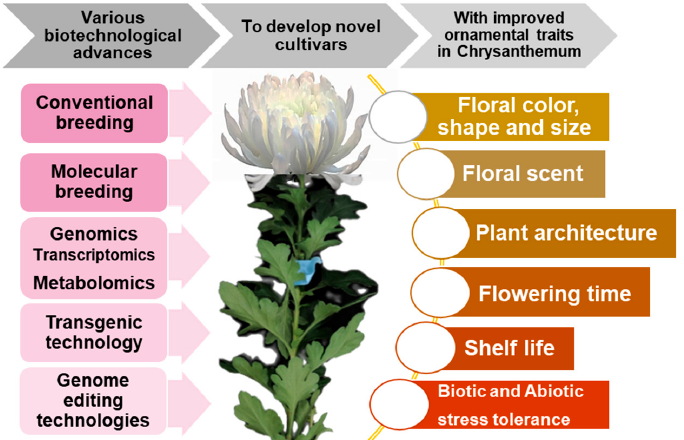
Figure 2. Brief illustration of various strategies and their application in the development of novel chrysanthemum cultivars with improved ornamental attributes.